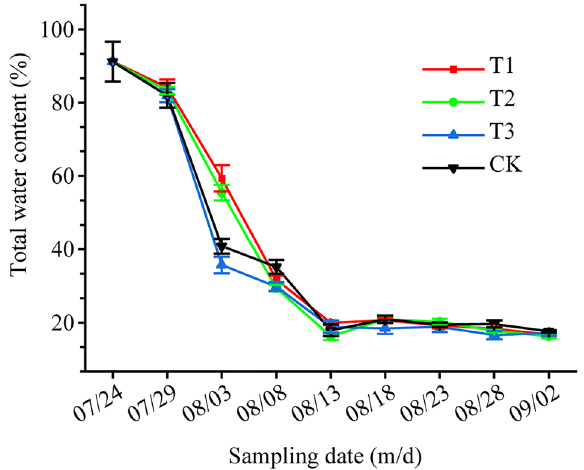
Figure 3. Changes in the total water content of tobacco leave in different treatments during the air-curing period. T1 (0.1 M sucrose), T2 (0.2 M sucrose), T3 (0.4 M sucrose) and CK (pure water). Values are the mean of three biological